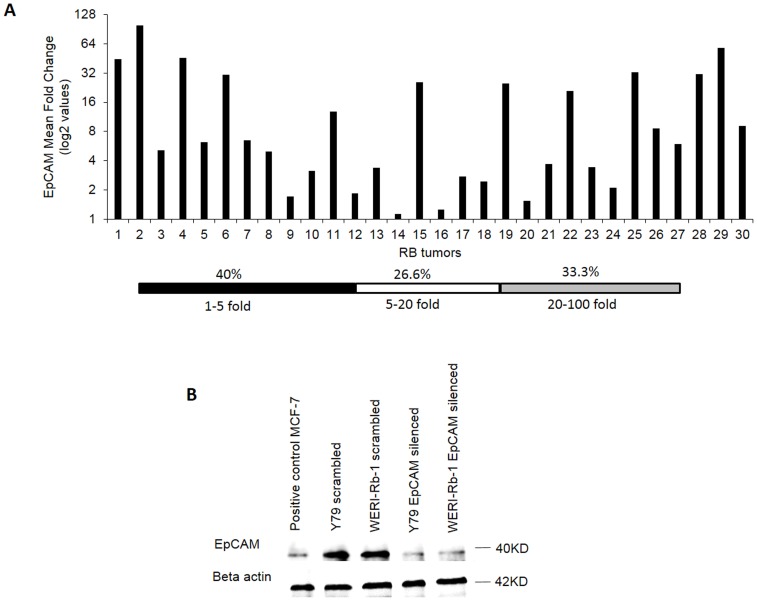
EpCAM is expressed in RB tumors.(A) EpCAM mRNA ranges from 2-100 fold in RB tumors (n = 30). Pooled non-neoplastic retinas (n = 3) was used as control. Data is expressed as fold change relative to control. (B) Immunoblot for protein levels of EpCAM siRNA knockdown in Y79 and WERI-Rb-1 cell lines.